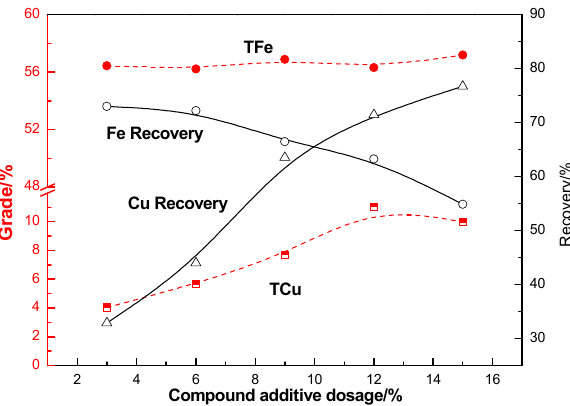
Figure 6. Effects of compound additive dosage on recovering of copper and iron (0.45 of binary basicity, modifying at 1350 °C for 120 min and cooling at 1.5 °C/min from 1350 to 900 °C).